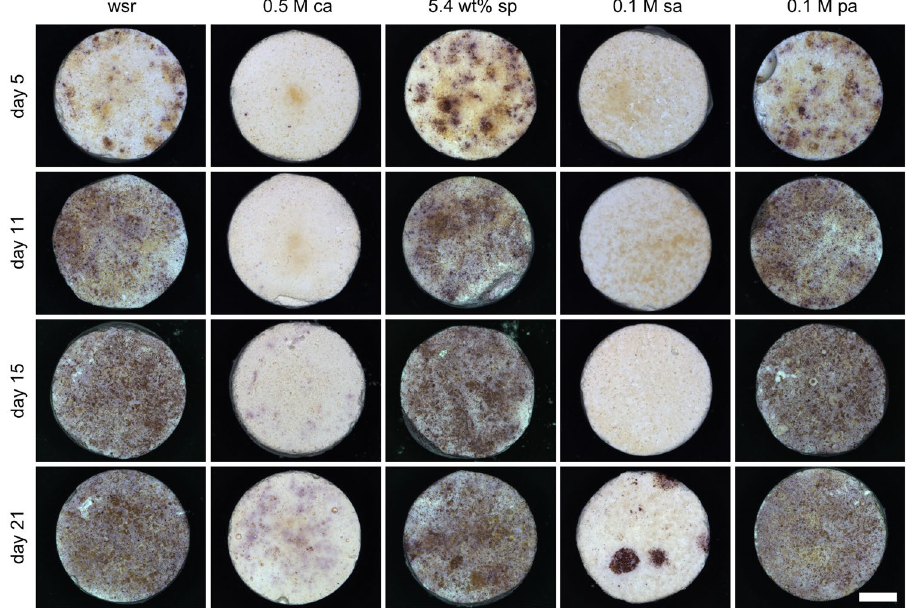
Figure 3. TRAP staining of RANKL treated RAW 264.7 cells. Differentiation can be seen for different setting retardants citric acid (0.5 M ca), sodium pyrophosphate (5.4 wt% sp), sulfuric acid (0.1 M sa) and phytic acid (0.1 M pa) as well as cement without setting retardant (wsr) over 21 days. Scale bar corresponds to 1.5 mm.